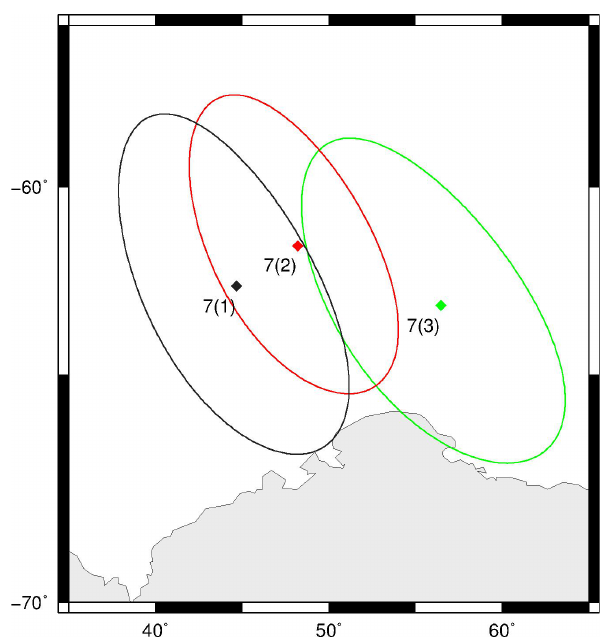
Fig. B3. 95% uncertainty ellipses for model 7 running with three different sets of UCCL. 7(1) corresponds to the crustal thickness ∼ 40km. Numbers 2 and 3 are are the limit of 37 and 34km respec-